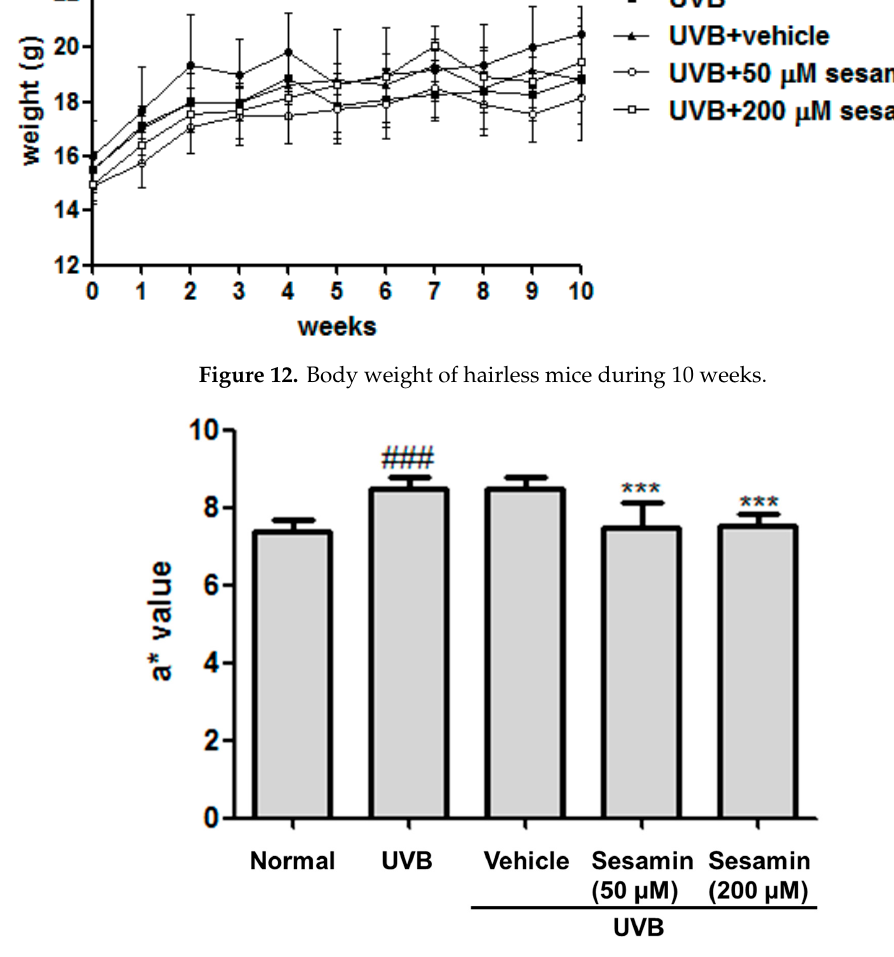
Figure 13. Effect of sesamin on the a* value in chronic UVB-irradiation hairless mice at the 10th week. Significant di ff erence versus normal group: ### p < 0.001. Significant di ff erence versus UVB group: *** p <